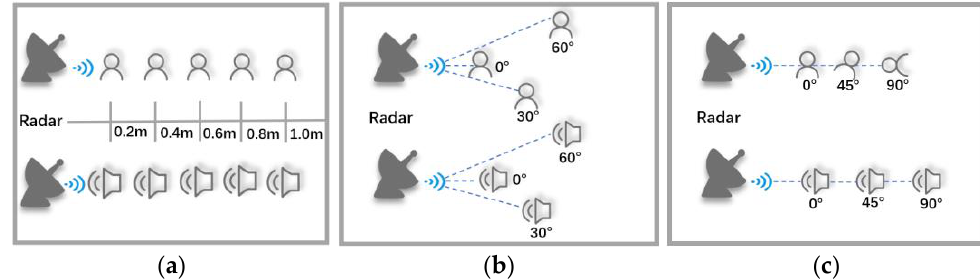
Figure 7. Experimental schematic of the spatial dimension: ( a ) Different distances; ( b ) different arrival angles; ( c ) different self-rotation angles.